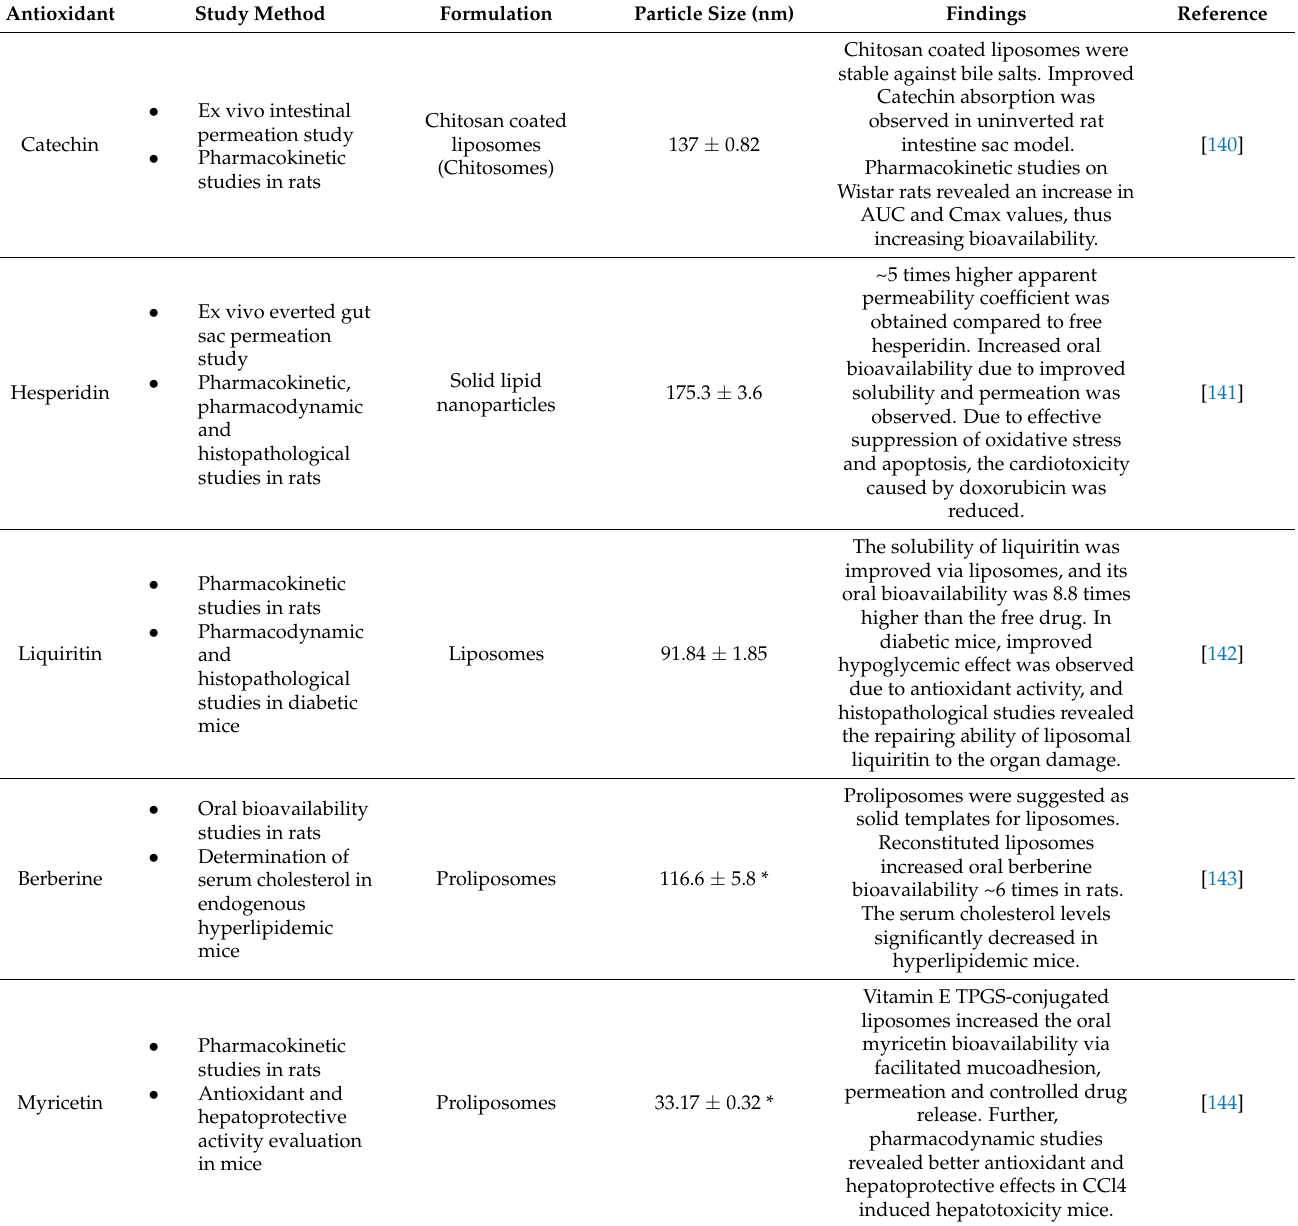
Table 8. Selected studies on NDDS-based formulations for improving the oral bioavailability of